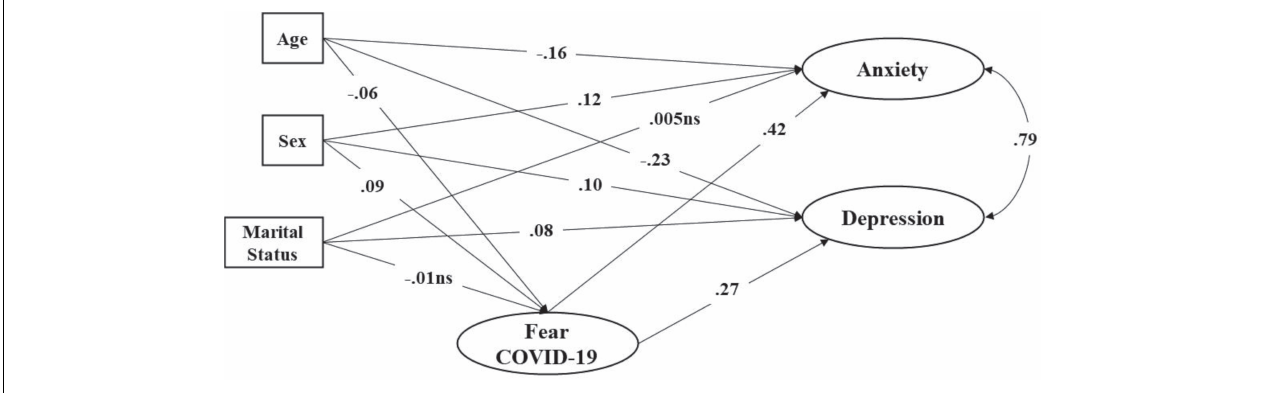
FIGURE 2 | Structural Equation Model of fear of COVID-19 predicting anxiety and depression. For the sake of clarity factor loadings and errors not shown; all estimates p < 0.01 unless stated as ns (non-significant).